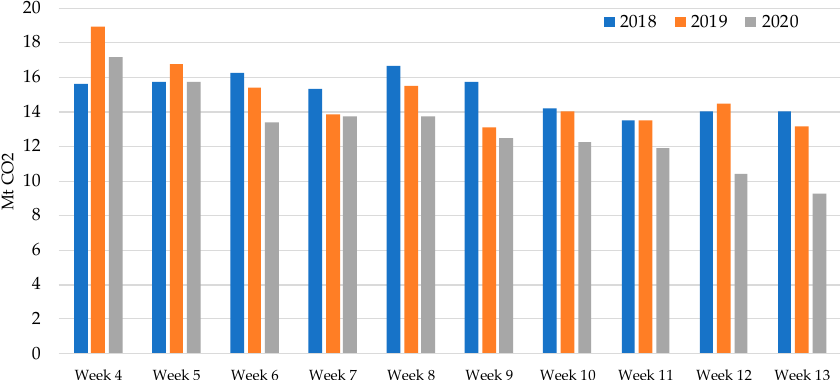
Figure 27. Weekly CO 2 emissions (in Mt) before and during COVID-19 lockdown in Italy.